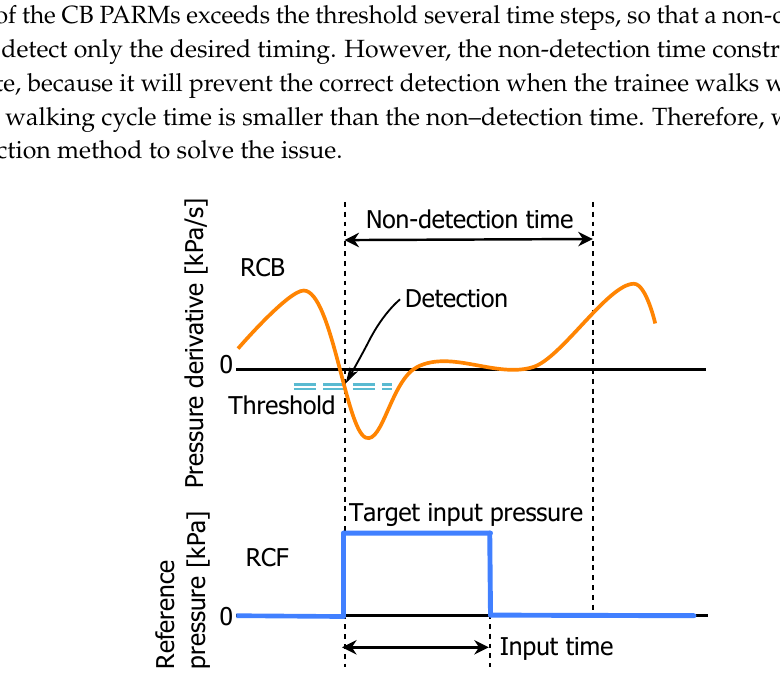
Figure 10. Control sequence of PARM pressure using conventional pre-swing phase